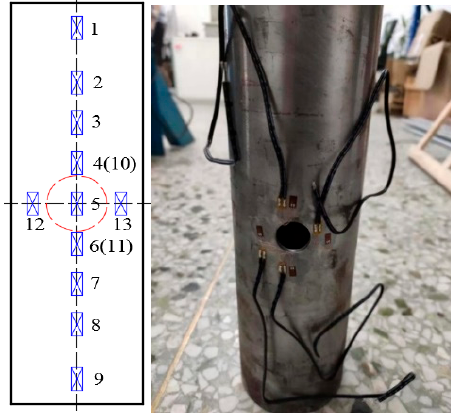
Figure 17. Sticking position of the defective steel pipe strain gauge.